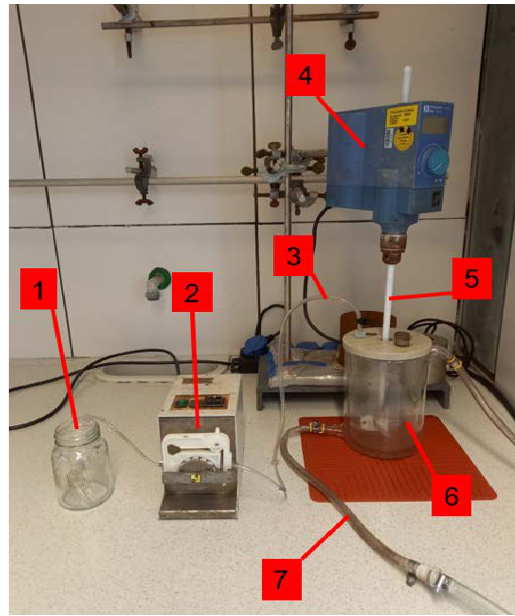
O reserve, 2—peristaltic pump, 3—tubes and inlet for H 2 2